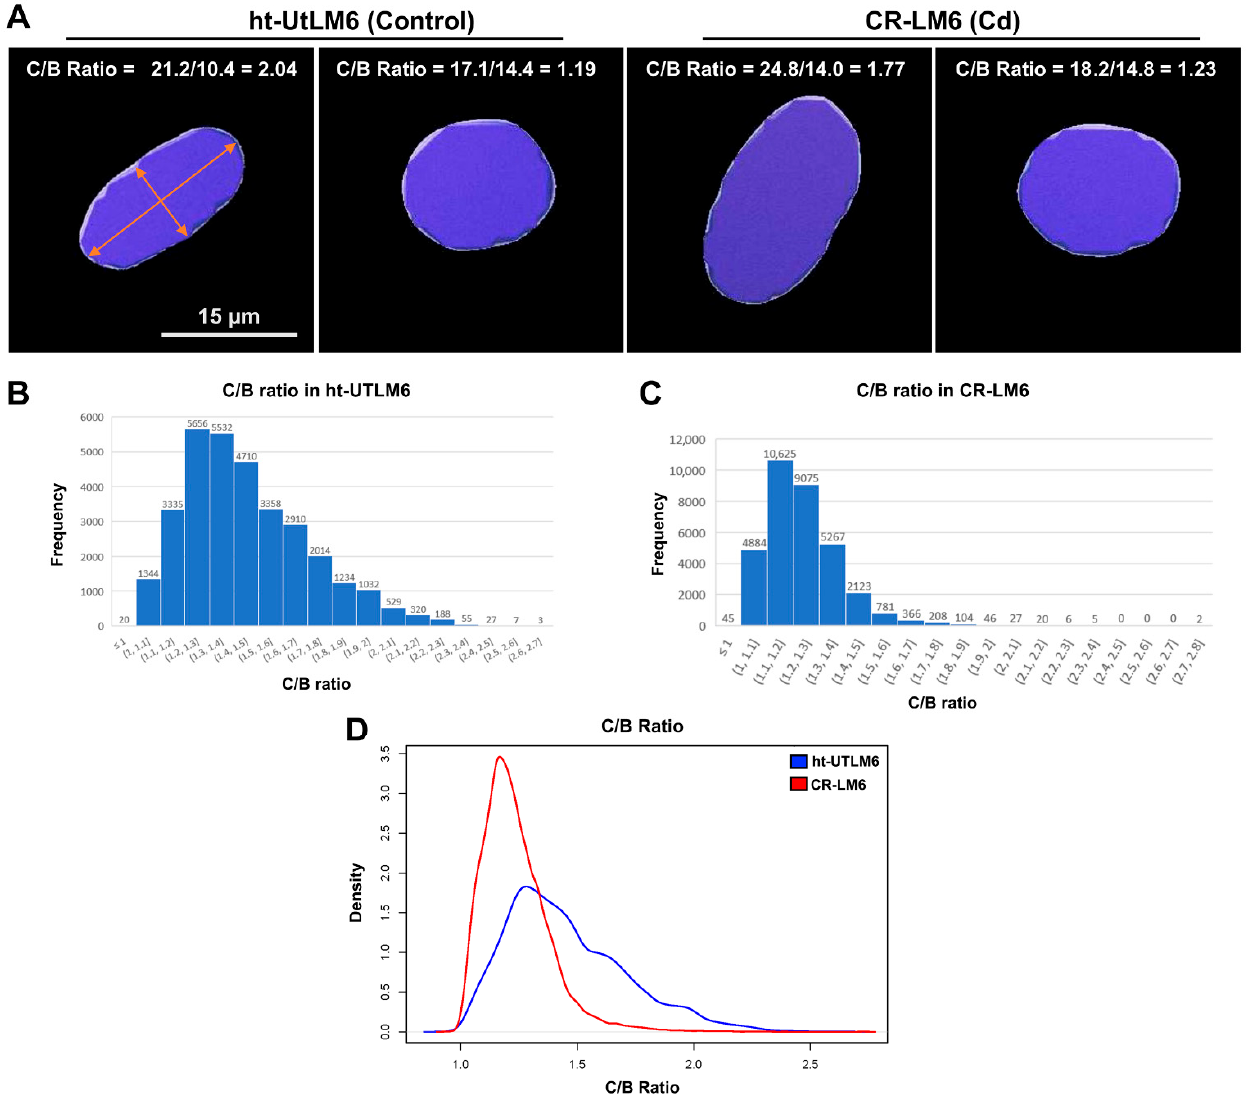
Figure 6. Cd exposure induced rounding of nuclei. ( A ) Shapes of selected nuclei with various C/B ratios from ht-UTLM6 and CR-LM6 populations. The C/B ratio is defined as ratio between the length of the longest principal axis of a nucleus and the length of the second longest principal axis. Scale bar = 15 µ m. ( B ) The distribution of C/B ratio in ht-UTLM6. The data labels shown on top of the bars are the absolute counts. ( C ) The distribution of C/B ratio in CR-LM6. ( D ) The overlay of inset B and inset C by probability density function. The x -axis is the C/B ratio and y -axis is probability density. As indicated in Figure 6B,C, the peak C/B ratio in the ht-UtLM6 population